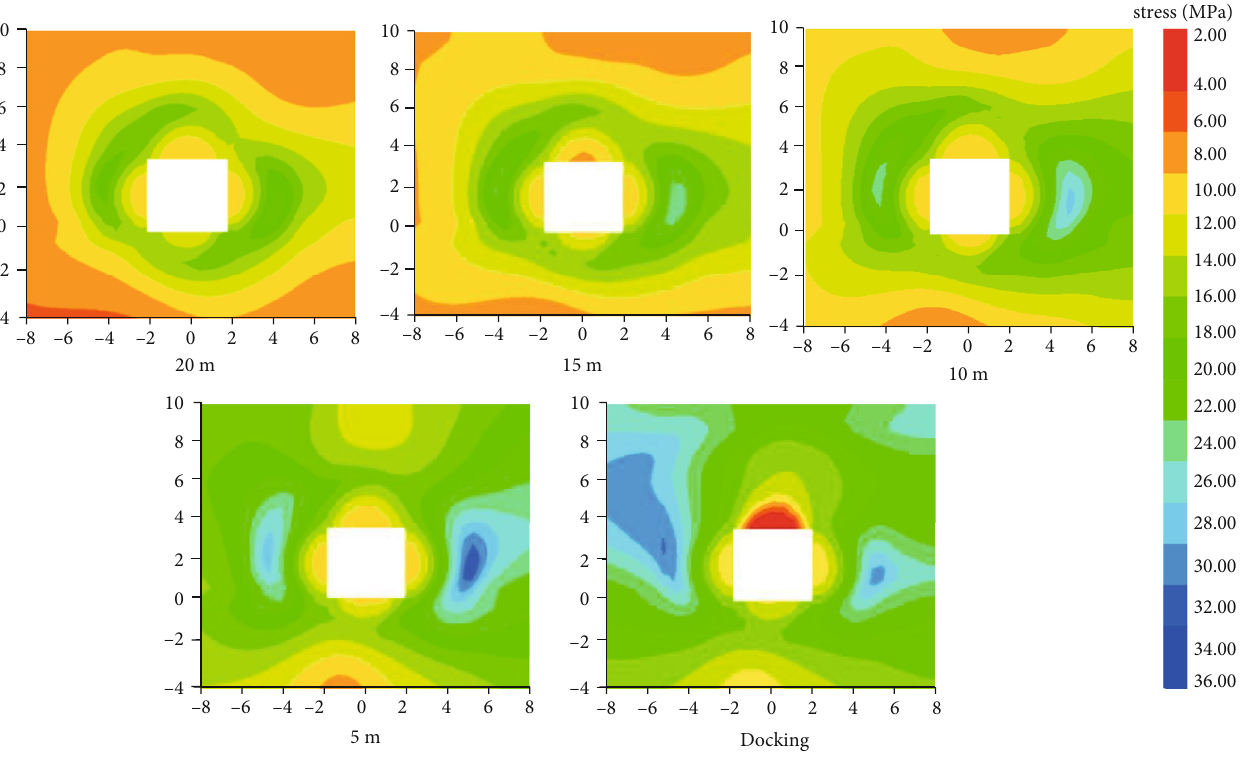
Figure 12: Nephogram of deviatoric stress.